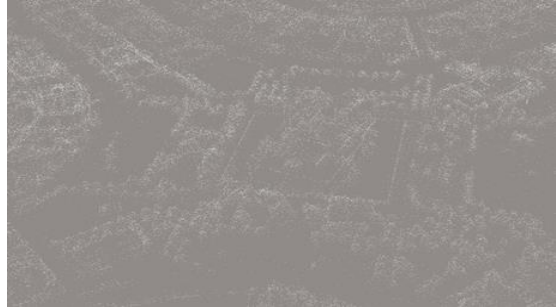
Figure 4. Point Cloud from 10cm Aerial Imagery.